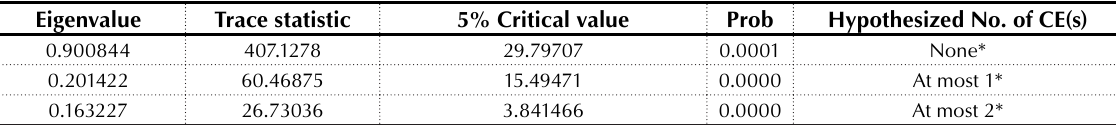
Source: researcher’s computation (2017).